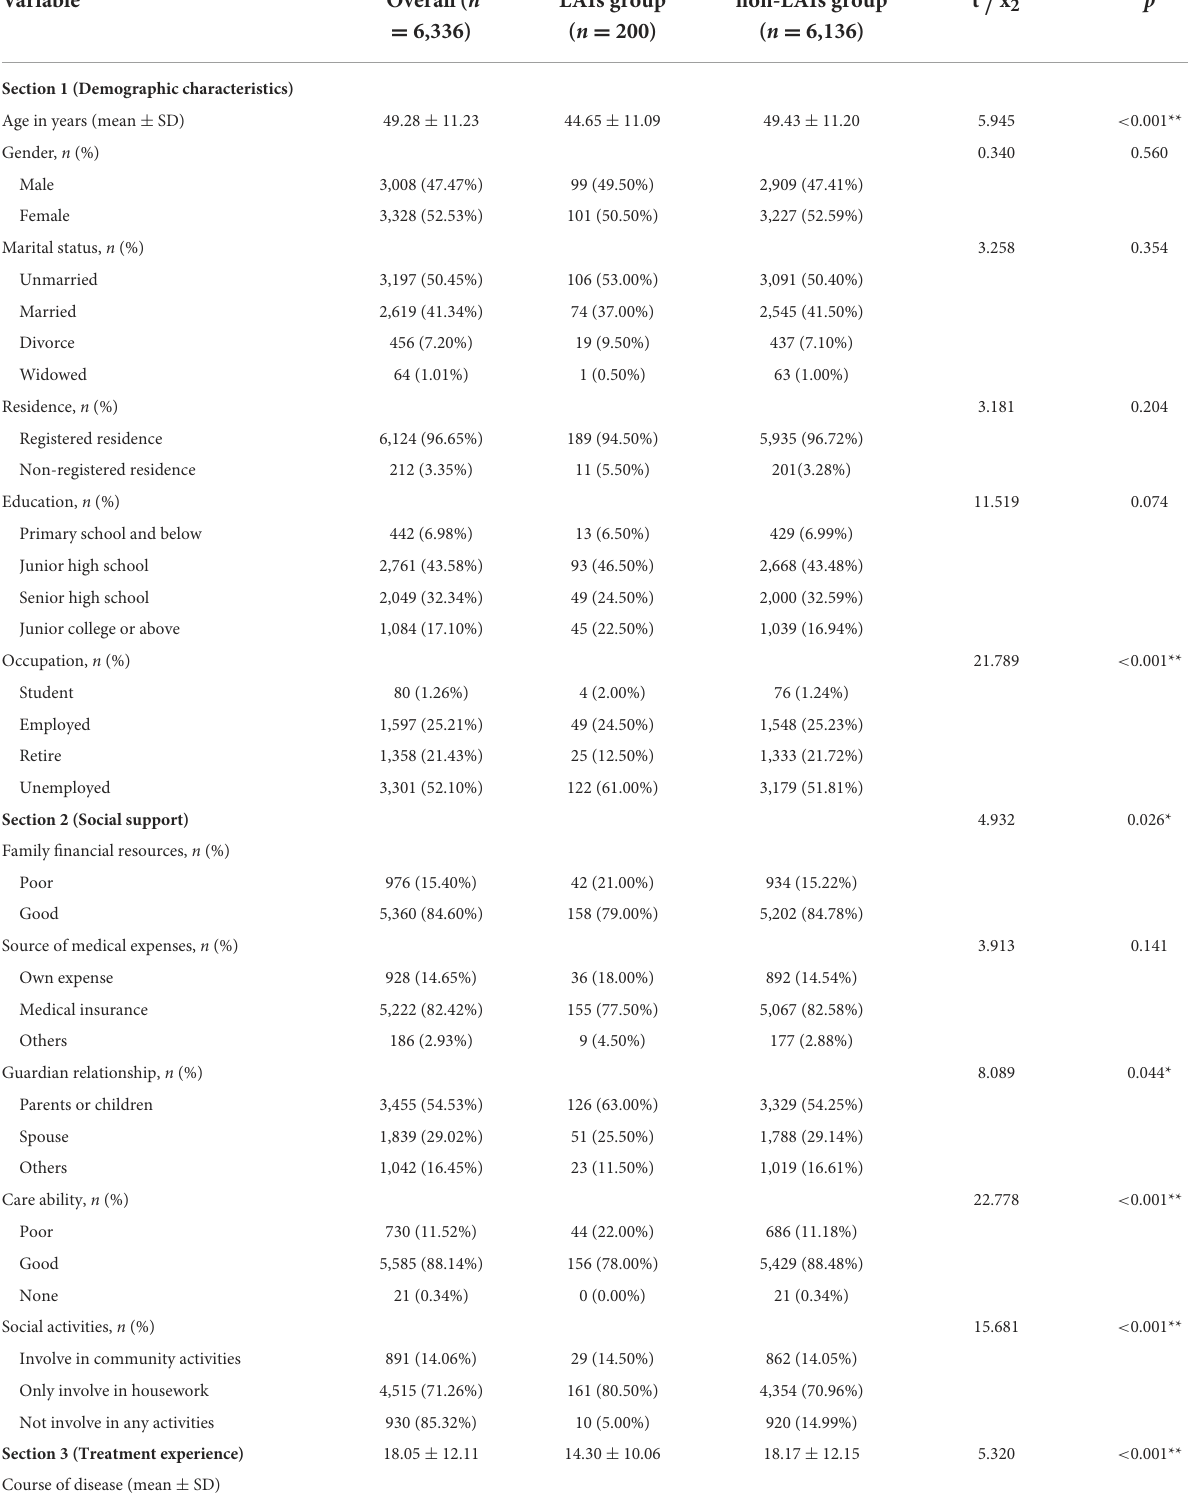
TABLE 2 Demographic characteristics, social support, treatment experience, and attitude toward antipsychotics of participants.